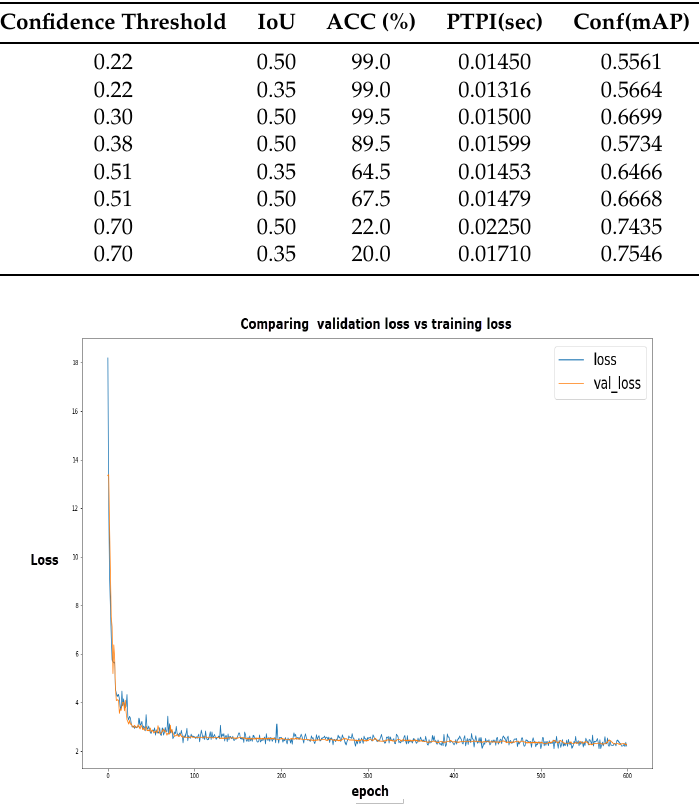
Figure 8. Comparing validation loss and training loss for SSD7 object detection ( epoch = 600).